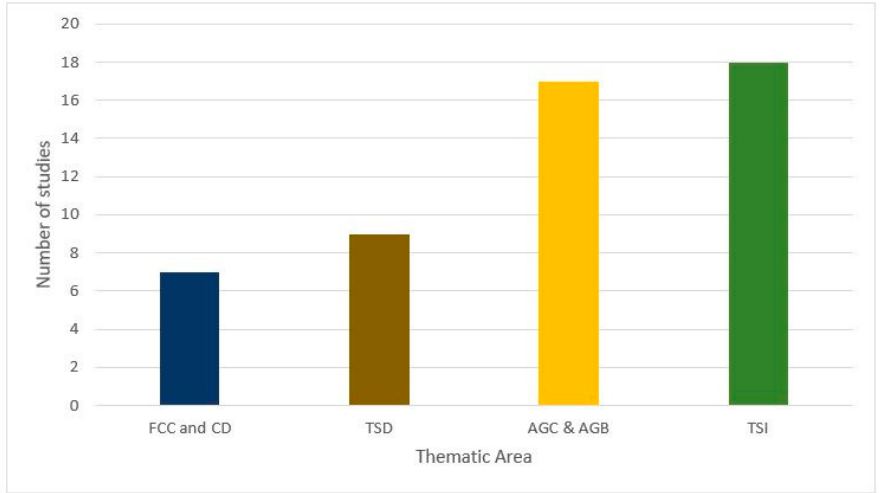
Figure 2. Number of studies carried out for each thematic area. Note: FCC and CD, forest cover change and change detection; TSD, tree species diversity; AGC and AGB, aboveground carbon and aboveground biomass; TSI, tree species identification. Table 1. Aboveground biomass and carbon estimation using remote